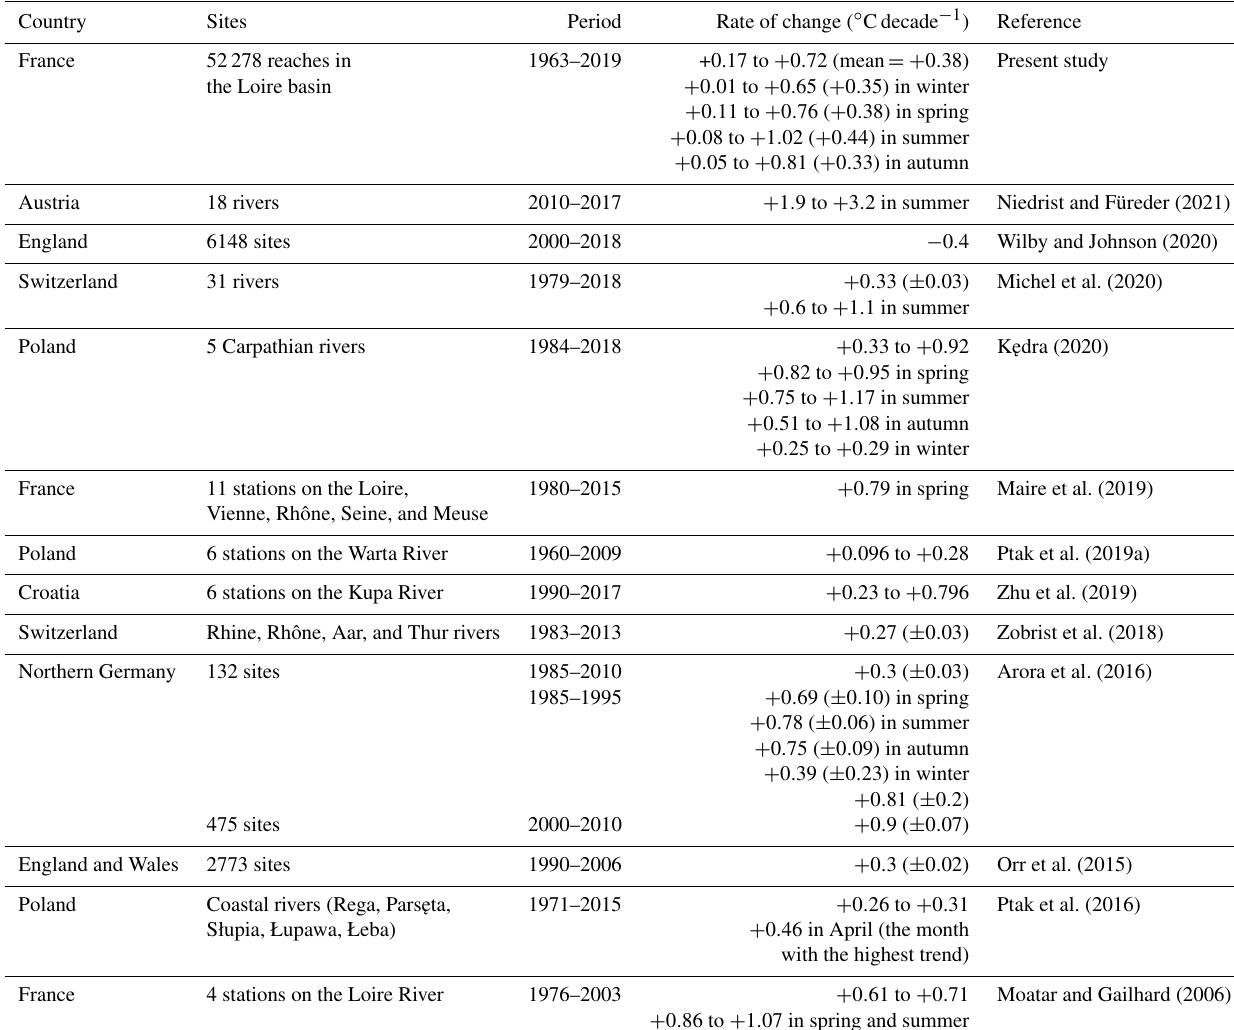
Table 3. Recent studies on T w trends in Europe. A comprehensive review of the relevant literature published prior to 2016 can be found in Arora et al. (2016). Magnitudes with unspecified seasons are related to the annual scale. Note that, except for the present study, the others used observed T w